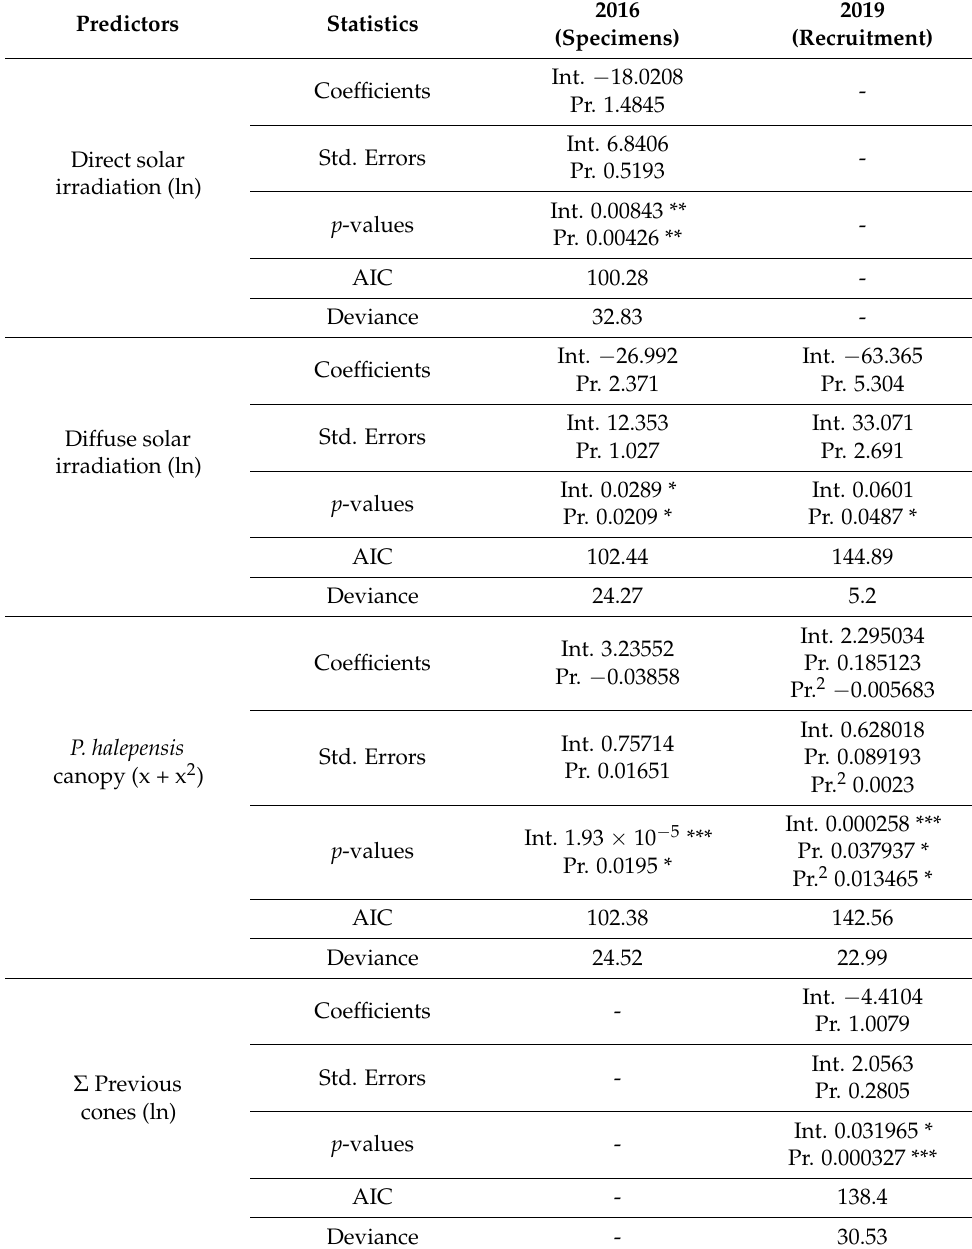
Table 6. Single predictors negative binomial GLM models obtained for the total number of specimens (2016) and the observed recruitment (2019). Int.: intercept, Pr.: predictor, Pr. 2 : quadratic